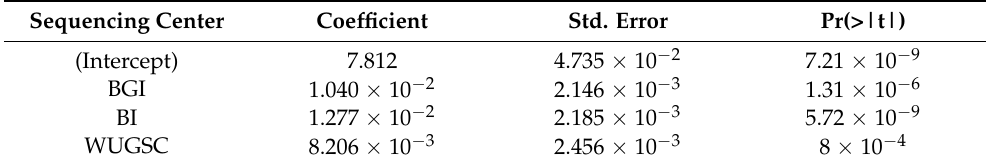
Figure 2. Number of loss of function (LoF) variants by sequencing centers across continental groups and populations. Each panel corresponds to a continental group. In the x -axis the name of the population is displayed; in the y -axis the number of LoF SNVs per individual is displayed. Acronyms are showed in Supplementary Materials Table S1. Table 2. Coefficient, standard error, and p value of the coefficient from the hierarchical mixed model using the number of benign variants as the dependent variable and the sequencing center as the independent variable. For this analysis, we only considered sequencing centers that sequenced samples across all populations.